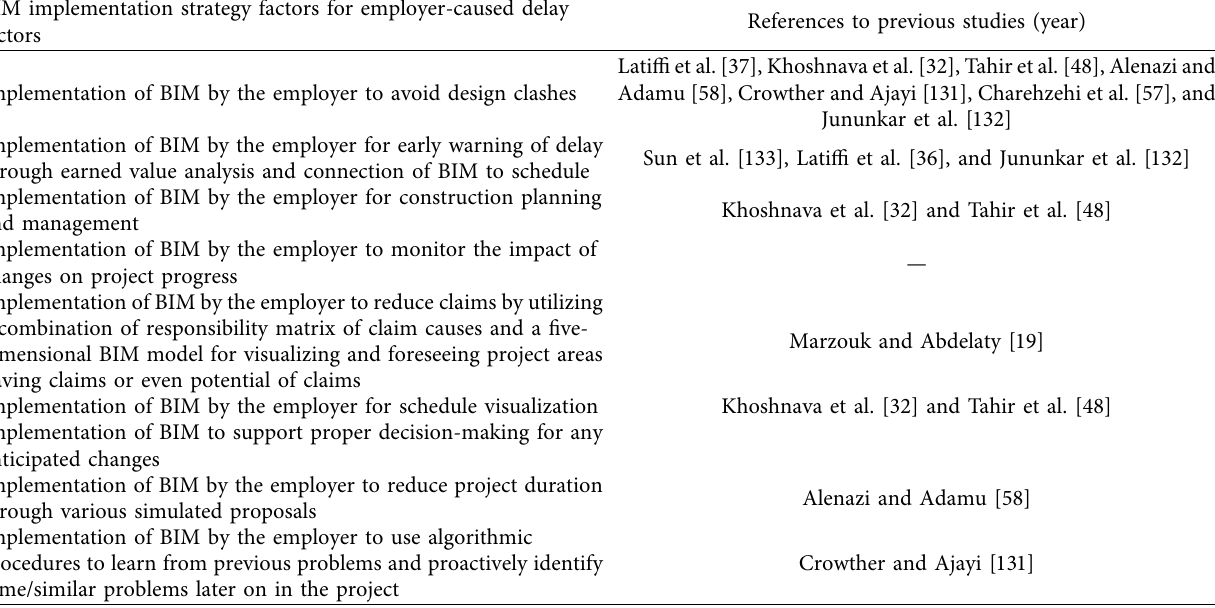
Table 10: BIM implementation strategies for employer-caused delay